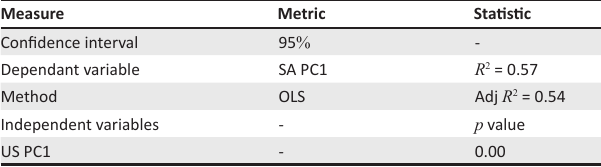
TABLE 6: Multivariate regression results: Sub-period 3.